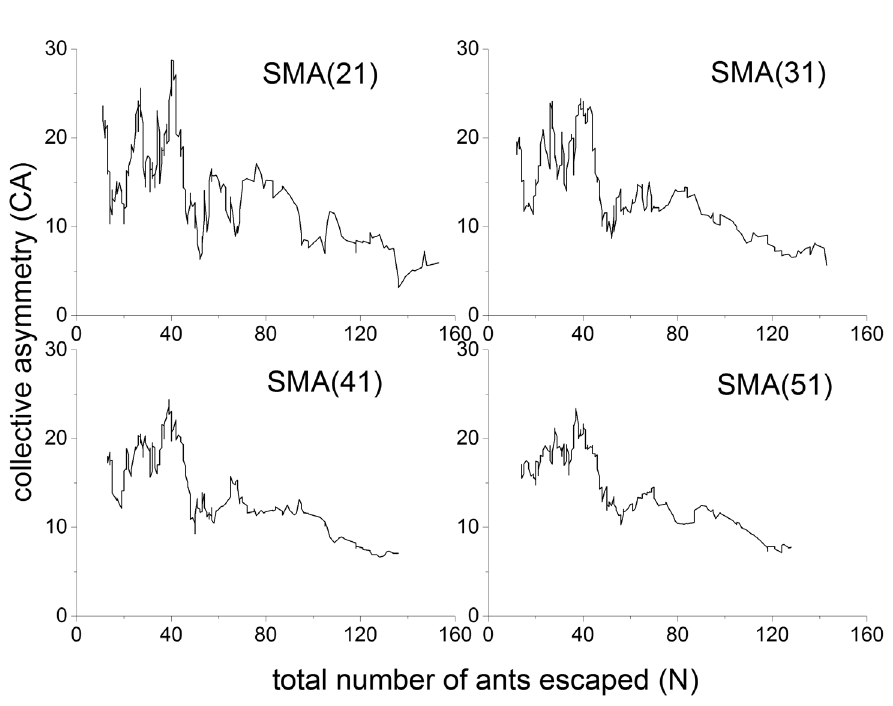
Fig. 8. Moving average of the collective asymmetry ( CA ) vs. the total number of escaped ants ( N ) when changing the period of the moving average to be 21, 31, 41 and 51. These data indicate that the initial increasing and then decreasing pattern in the experiment does not depend on parameter